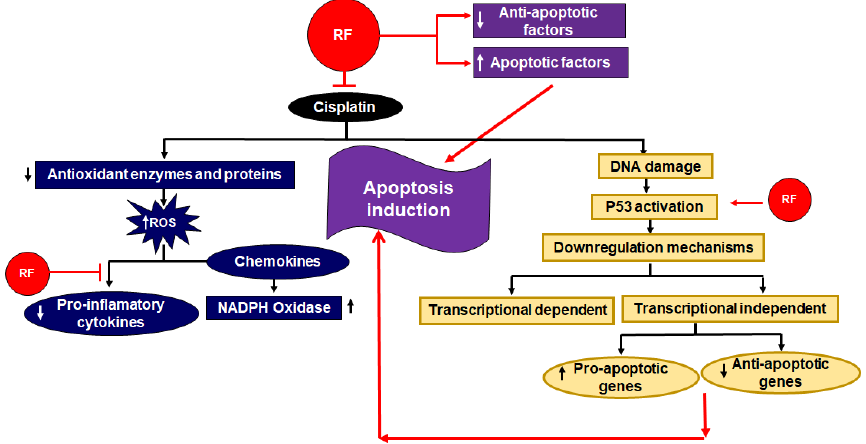
Figure 6. Role of RF as an adjuvant in cisplatin based chemo radiotherapy [75]. RF stimulates apoptotic factors and downregulates anti-apoptotic factors. Additionally, it activates p53, which also results in an amplification of apoptosis. The inhibitory e ff ects of RF in respect to the deteriorate e ff ect of cisplatin are also shown. On the one hand, it inhibits the downregulation of antioxidant enzymes and proteins; on the other, RF downregulates pro-inflammatory